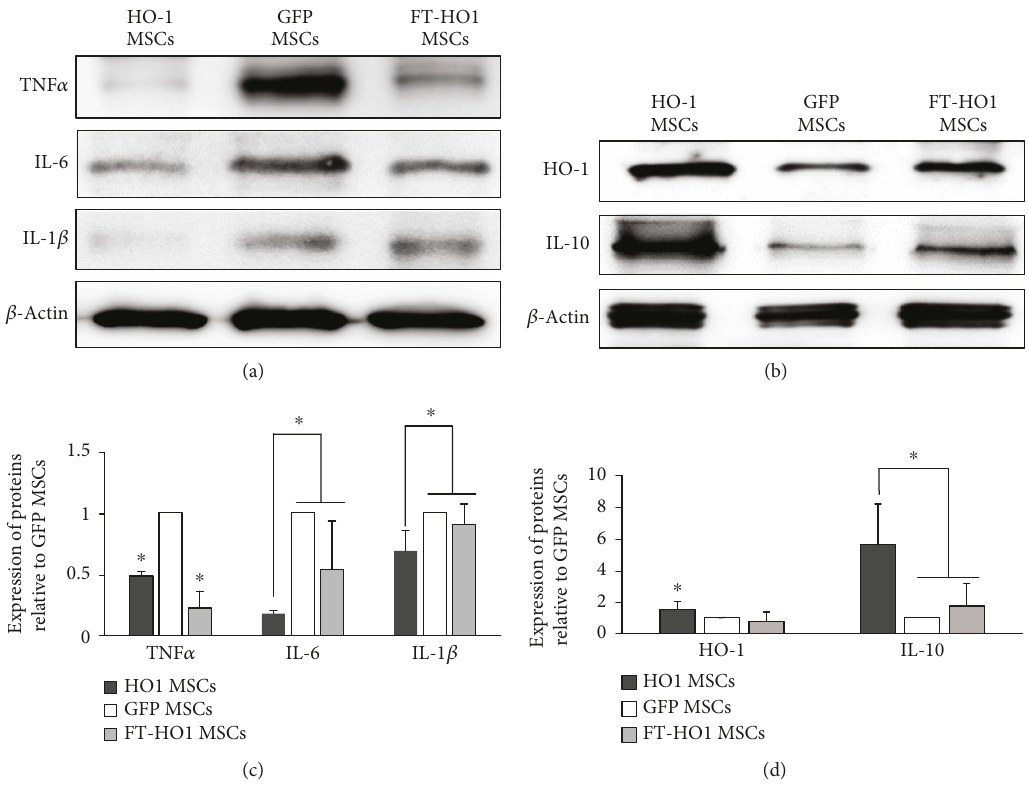
Figure 7: Expression of in fl ammatory and anti-in fl ammatory cytokines. (a) Representative densities of markers for in fl ammatory cytokines. (b) Representative densities of markers for anti-in fl ammatory cytokines. (c, d) Quantitative analysis of densities obtained for markers related to in fl ammatory and anti-in fl ammatory cytokines. Each bar represents the average of 4 samples per group and error bars represent standard error. ∗ Indicates signi fi cance at p ≤ 0 05